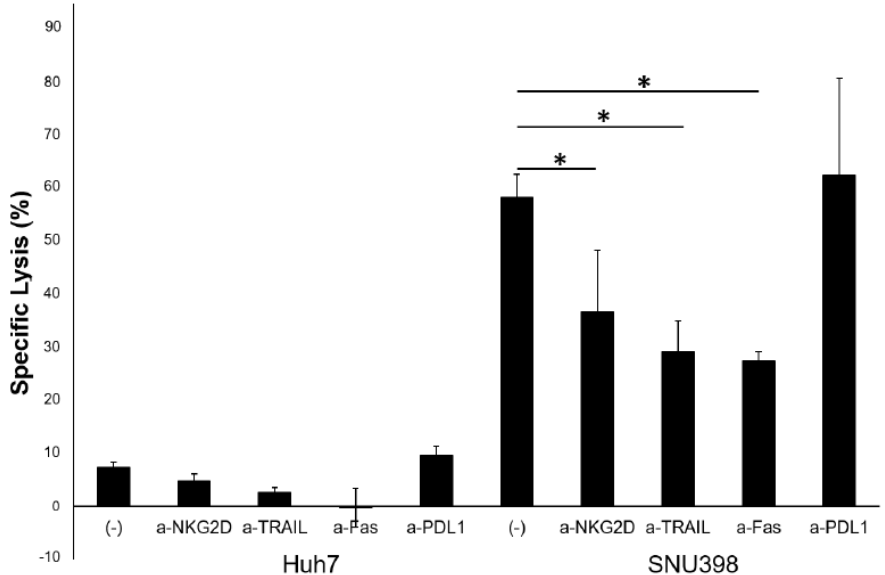
Figure 5. Strong cytotoxicity of HI mononuclear cells against SNU398 cells attributing to NKG2D, TRAIL, and FAS. LDH assay was performed with pretreated HI mononuclear cells with anti-NKG2D, anti-TRAIL, or anti-FAS mAbs, and HCC cells pretreated with or without anti-PD-L1 mAb. Effector to target (E:T) ratio was 20:1. ( − ), negative control treated with blocking Ab and isotype control. The results are representative of three independent experiments. The error bars represent SD of triplicates. * p < 0.05.